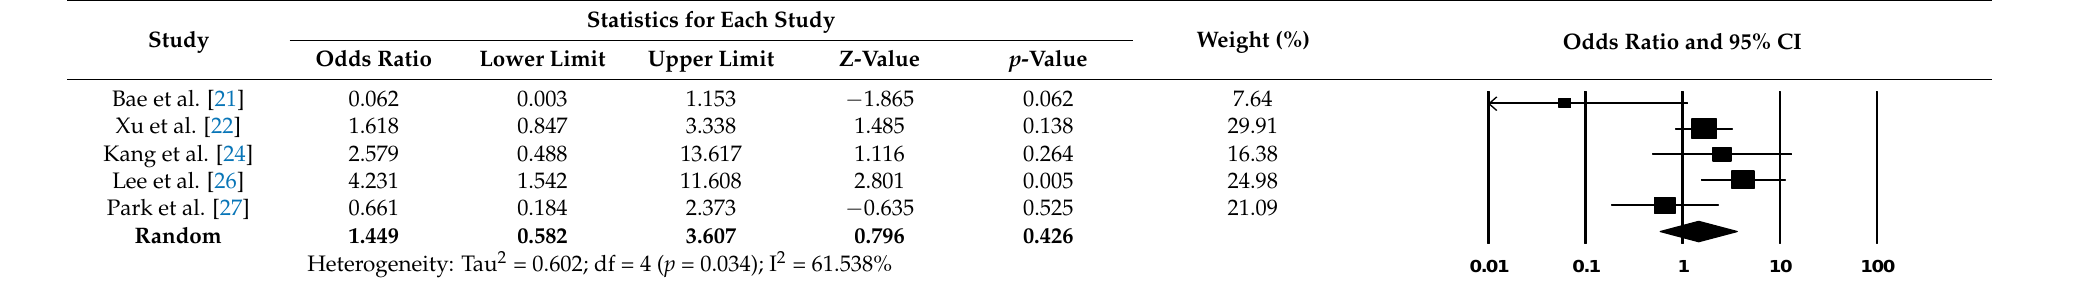
Table 3. Association between TSH maintenance less than 2 mU/L and recurrence rate in patients with lobectomy for low-risk differentiated thyroid cancer.